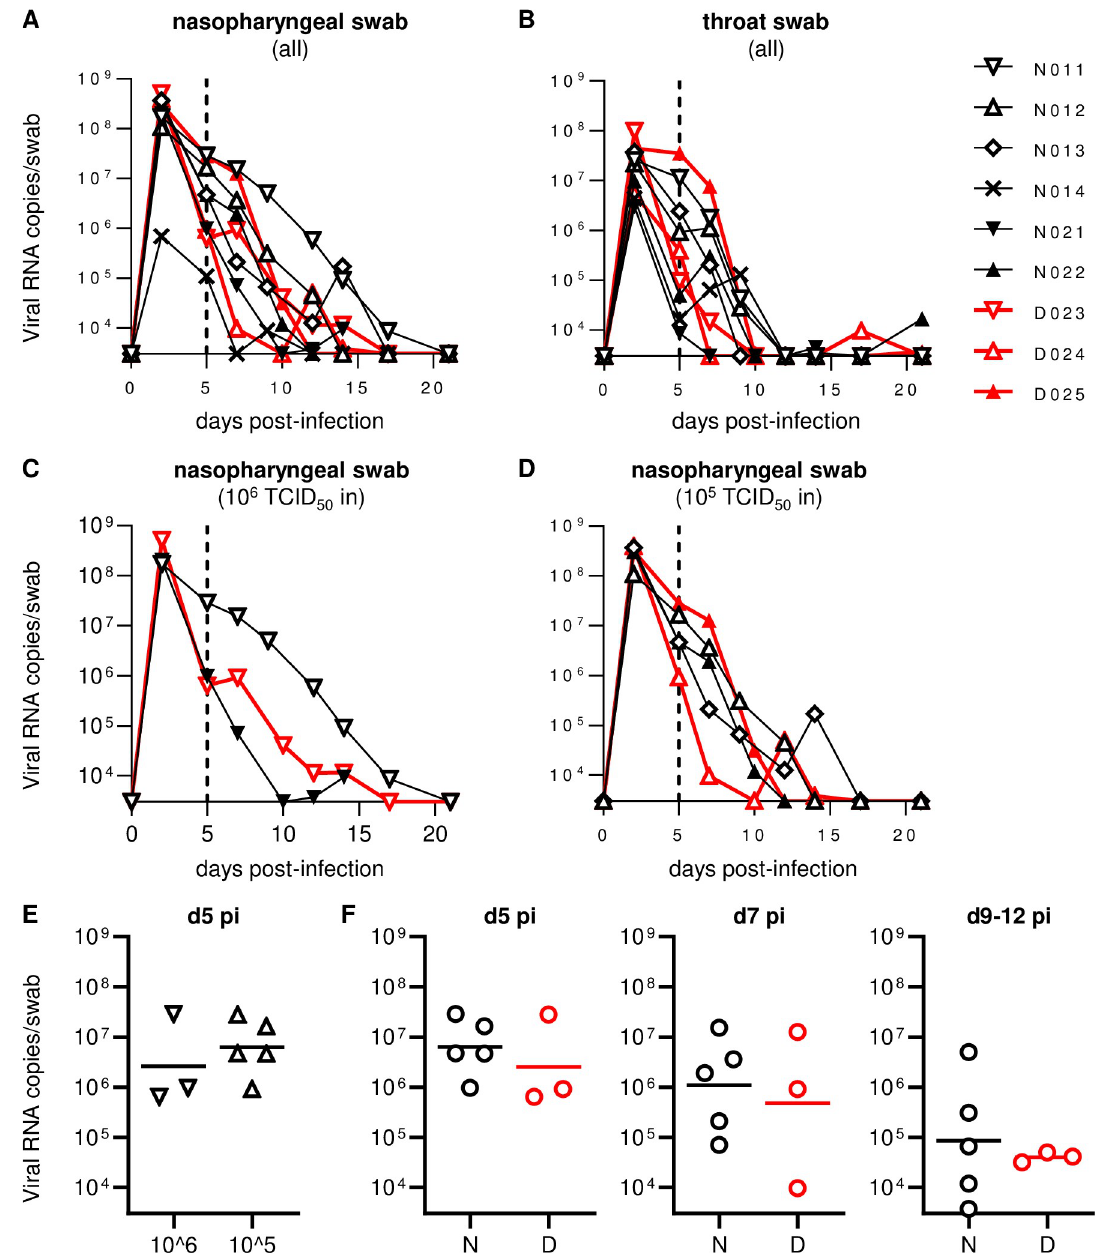
Fig 1. Viral RNA levels in swabs. (A-D) Changes in viral RNA levels in nasopharyngeal (A, C, D) and throat (B) swabs after SARS-CoV-2 infection in all animals (A, B) or those infected with 10 6 (C) or 10 5 (D) TCID 50 of SARS-CoV-2. The lower limit of detection was approximately 3 x 10 3 copies/swab. (E) Comparison of viral RNA levels in nasopharyngeal swabs at day 5 post-infection between 10 6 TCID 50 -infected and 10 5 TCID 50 -infected macaques. No significant difference was observed. (F) Comparison of viral RNA levels in nasopharyngeal swabs at days 5 (left), 7 (middle), and 9–12 (right) post-infection between Group N and D animals infected with 10 6 or 10 5 TCID 50 of SARS-CoV-2. No significant difference was observed.